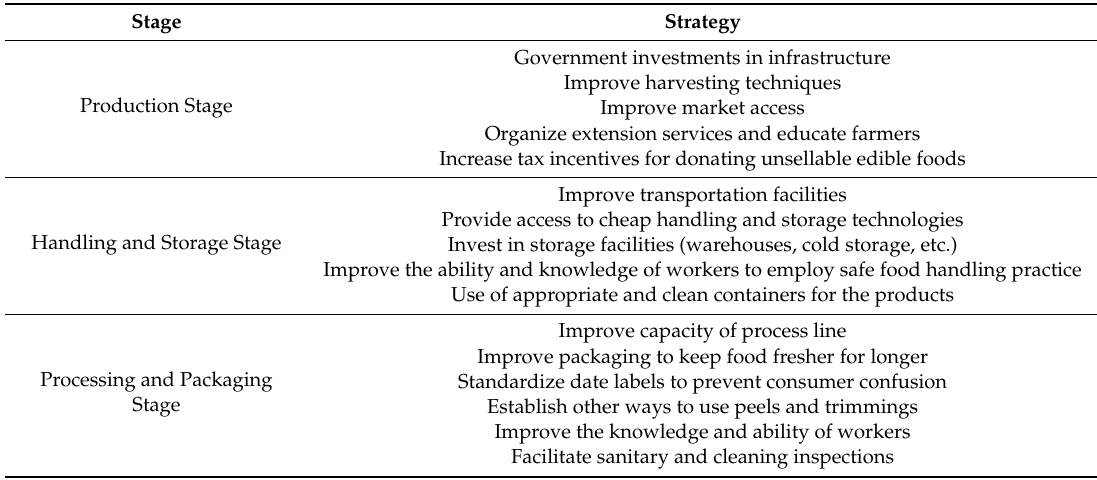
Table 12. Possible strategies to prevent the FLW at di ff erent stages of